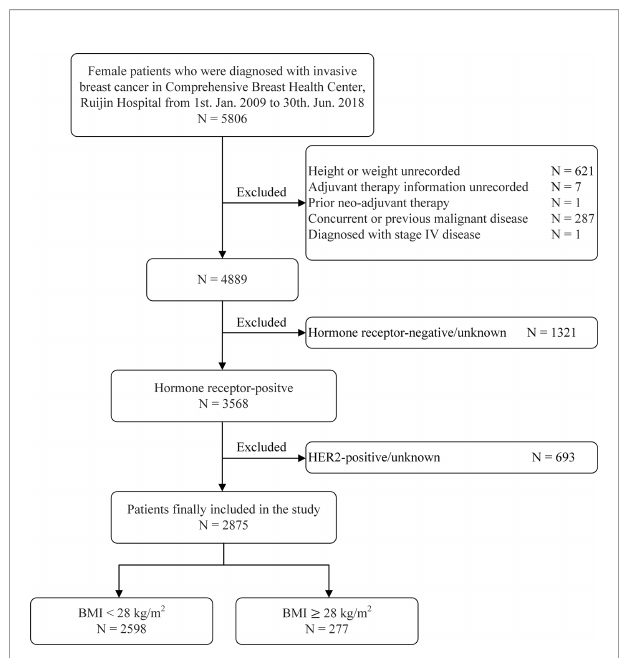
FIGURE 1 | Study fl ow chart. BMI, body mass index; HER2, human epidermal growth factor receptor